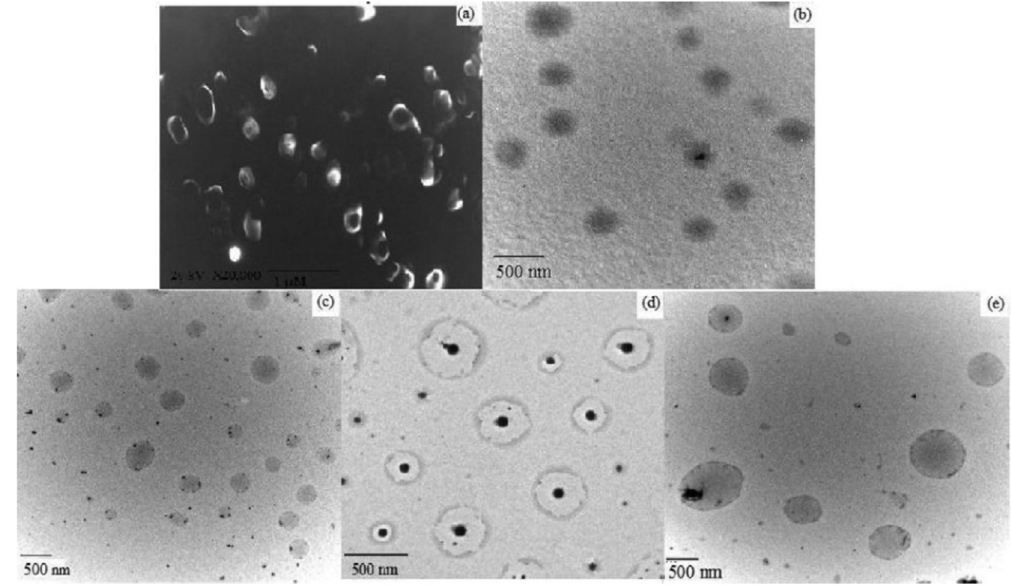
Figure 5. ( a ) SEM image of blank niosomes. TEM images of ( b ) black, ( c ) RIF, ( d ) INH and ( e ) PZA encapsulated niosomes. Reproduced with permission from [52] , published by Elsevier,